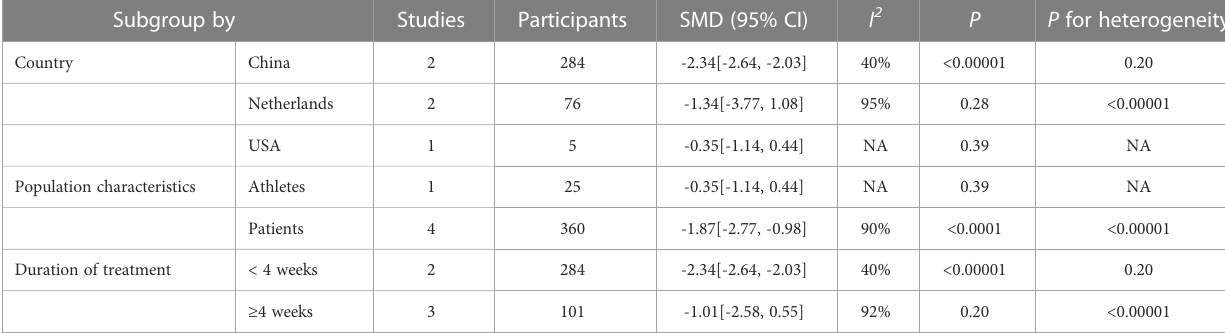
TABLE 3 Subgroup analysis of serum zonulin. Subgroup by Studies